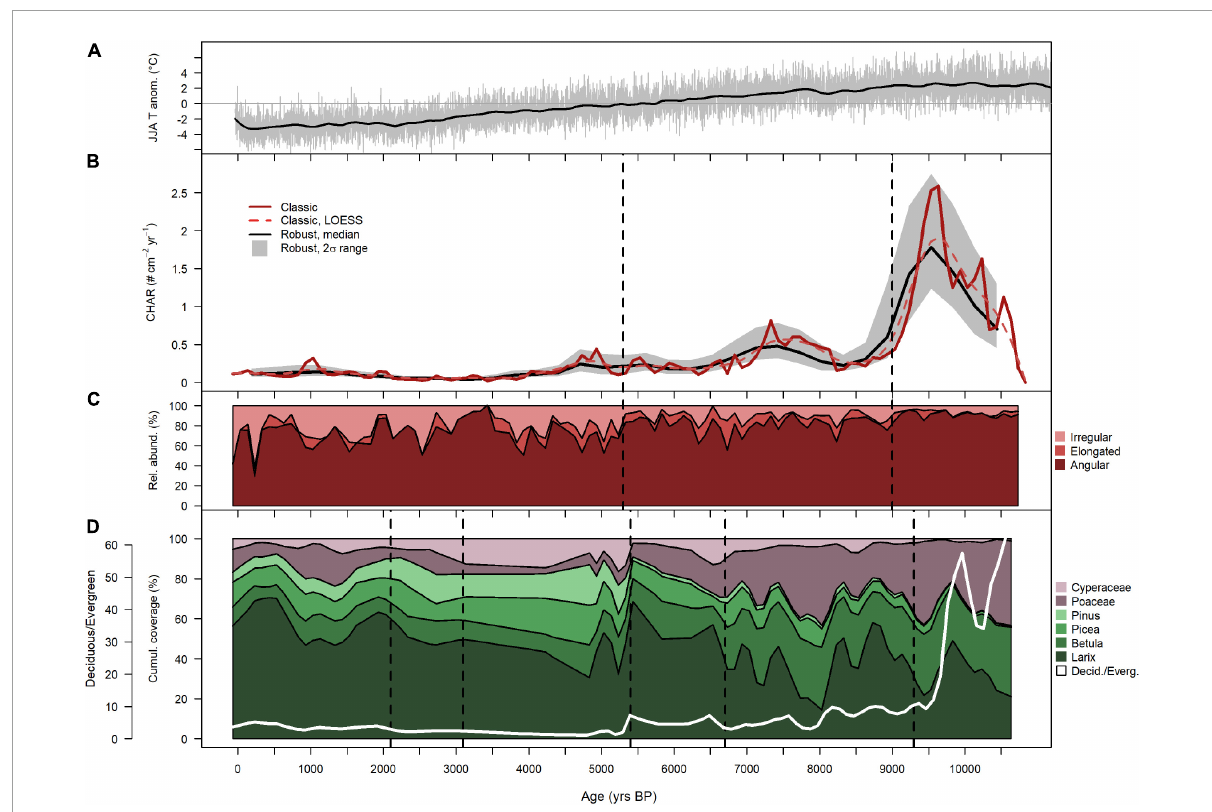
FIGURE4 (A) TraCE 21ka climate model data (He, 2011) for Lake Satagay, displayed as annual June–August (JJA) temperature anomaly. (B) Classic and robust charcoal accumulation rates (CHAR), with zone separations from cluster analysis. (C) Relative abundance of charcoal morphotype classes, with zone separations from cluster analysis. (D) Cover of the most prominent vegetation types from the REVEALS-transformed pollen data, interpolated to match the median temporal resolution of the displayed charcoal data and with zone separations from cluster analysis (applied to interpolated